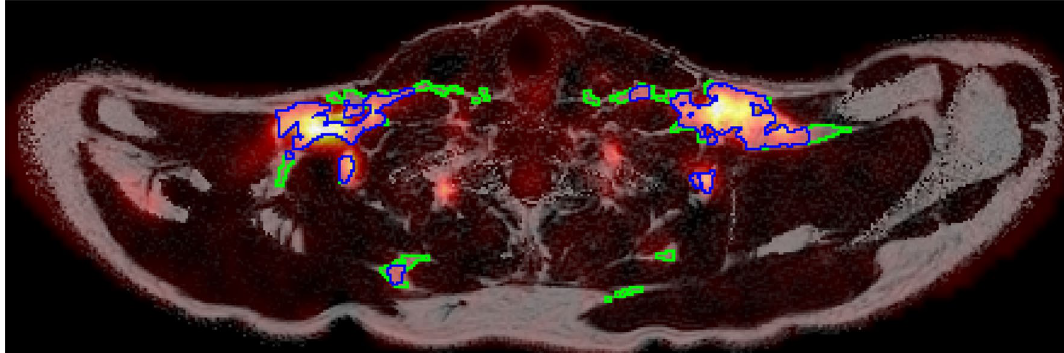
Figure 2. Example of an axial FF map (greyscale) overlaid with the corresponding MR glu map (heat colour scale) and segmentations representing sBAT HI (blue contour) and sBAT LO (green